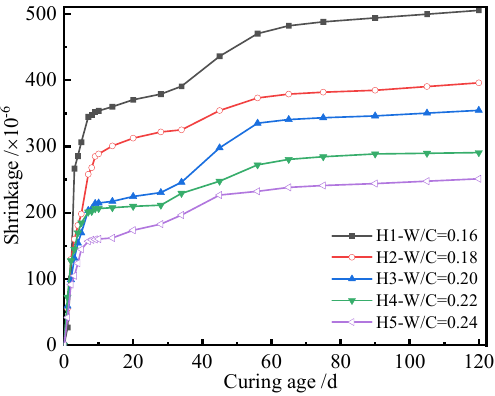
Figure 2. Shrinkage curves of the UHPC with W/C .